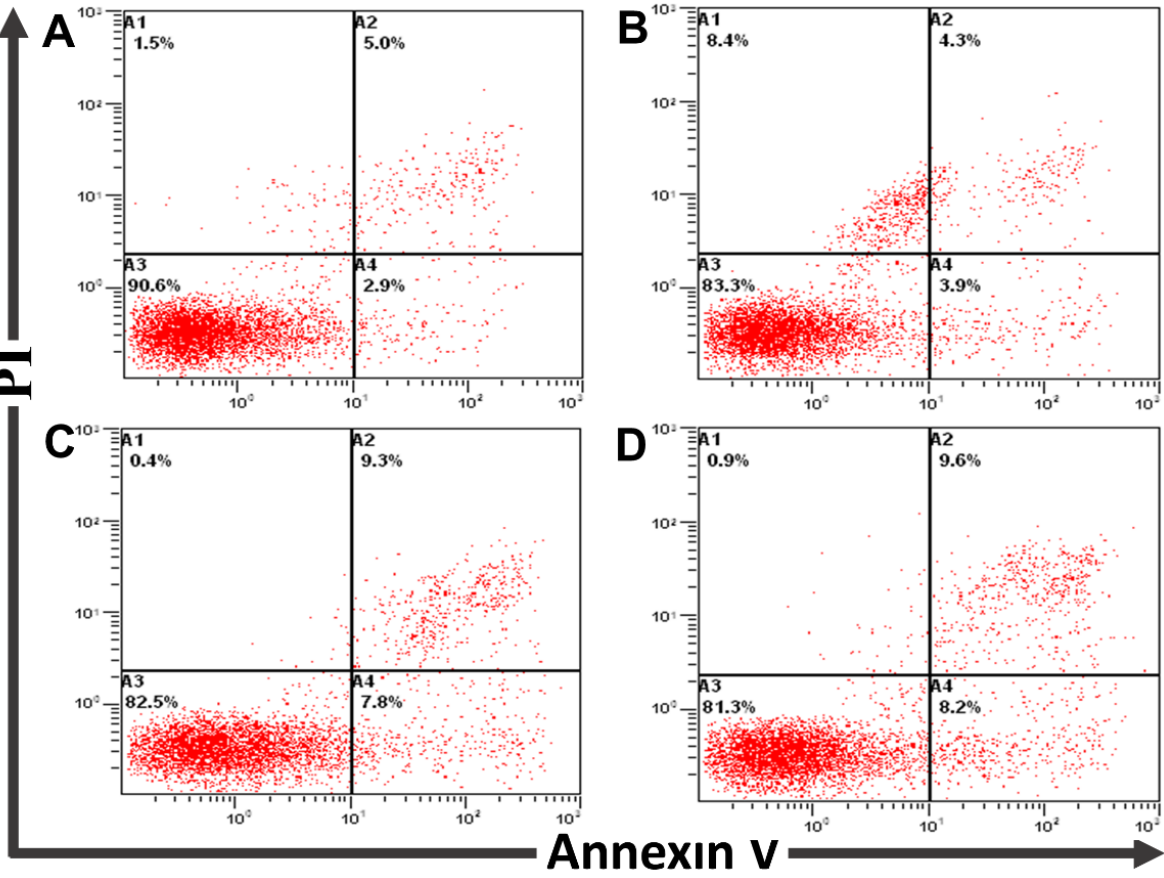
Figure 13. Detection of early/late apoptosis in MCF7 cells treated with 16g using annexin V FITC/PI staining assay for 72 h ( n = 3), x -axis: annexin V, y -axis: PI; ( A ); 0 µ M; ( B ): 0.01 µ M; ( C ): 0.05 µ M; ( D ): 0.10 µ M. Top left quarter: necrosis (PI+/annexin V − ); top right quarter: late apoptosis (PI+/annexin V+); bottom left quarter: living cells (PI-/annexin V − ); bottom right: early apoptosis (PI-/annexin V+).